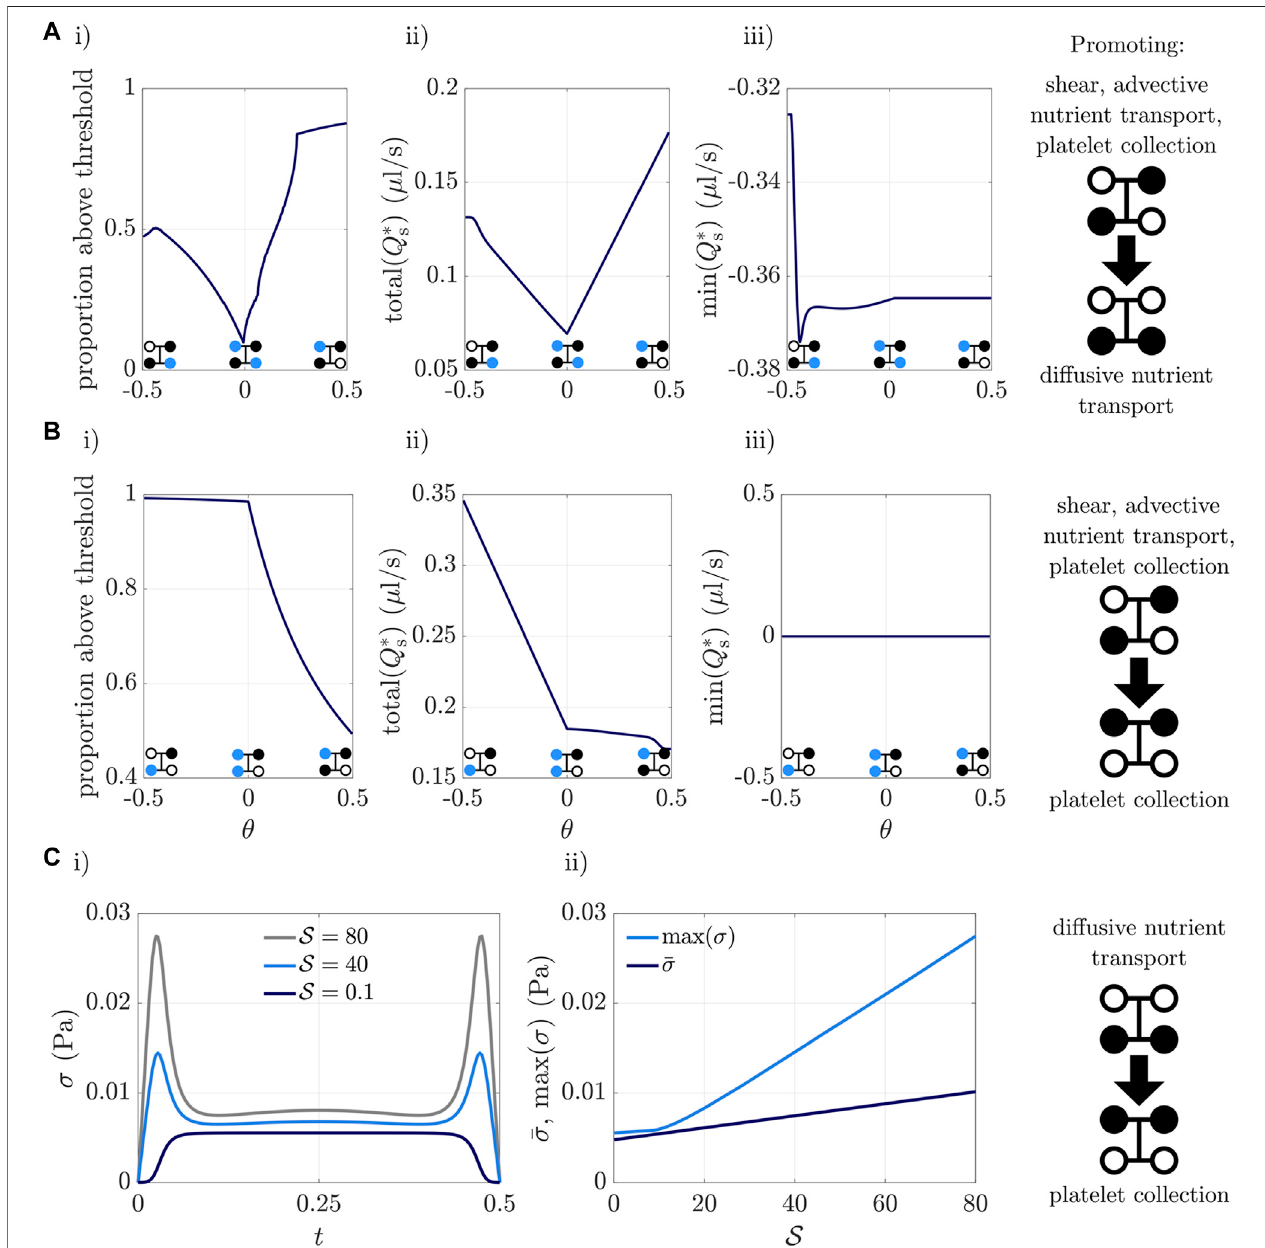
FIGURE7|(Ai,Bi) Proportionofthetotaltimethevalvesaremoving,forwhichtheshearstressisaboveanillustrativethresholdvalueof6.5×10 – 3 Pa, (Aii,Bii) total scaffold fl ux over the time at least one valve is moving, and (Aiii,Biii) minimum instantaneous scaffold fl ux. Here relative delay time θ between valves is varied while transitioningbetweentwostaticcon fi gurations,shownontherightpanels.Thebluedotsinthevalvediagramsindicatewhichvalve(s)startsmoving fi rstatthatvalueof θ . (C) Shear stress dependence on Strouhal number, i.e., on valve speed (fast for high S , slow for low S ). (Ci) Shear stress while closing upper valves and opening lower valves, with valves moving in sync, for S (cid:2) 0 . 1 , 40 , 80. (Cii) Maximum instantaneous shear stress max( σ ), and time-averaged shear stress (cid:2) σ for S ∈ [ 0 . 1 , 80 ] . Lengthscales are b v * (cid:2) 4 . 9 × 10 − 4 (cid:2) b c *, b r * (cid:2) 10 − 4 , and other parameters are as in Table 1